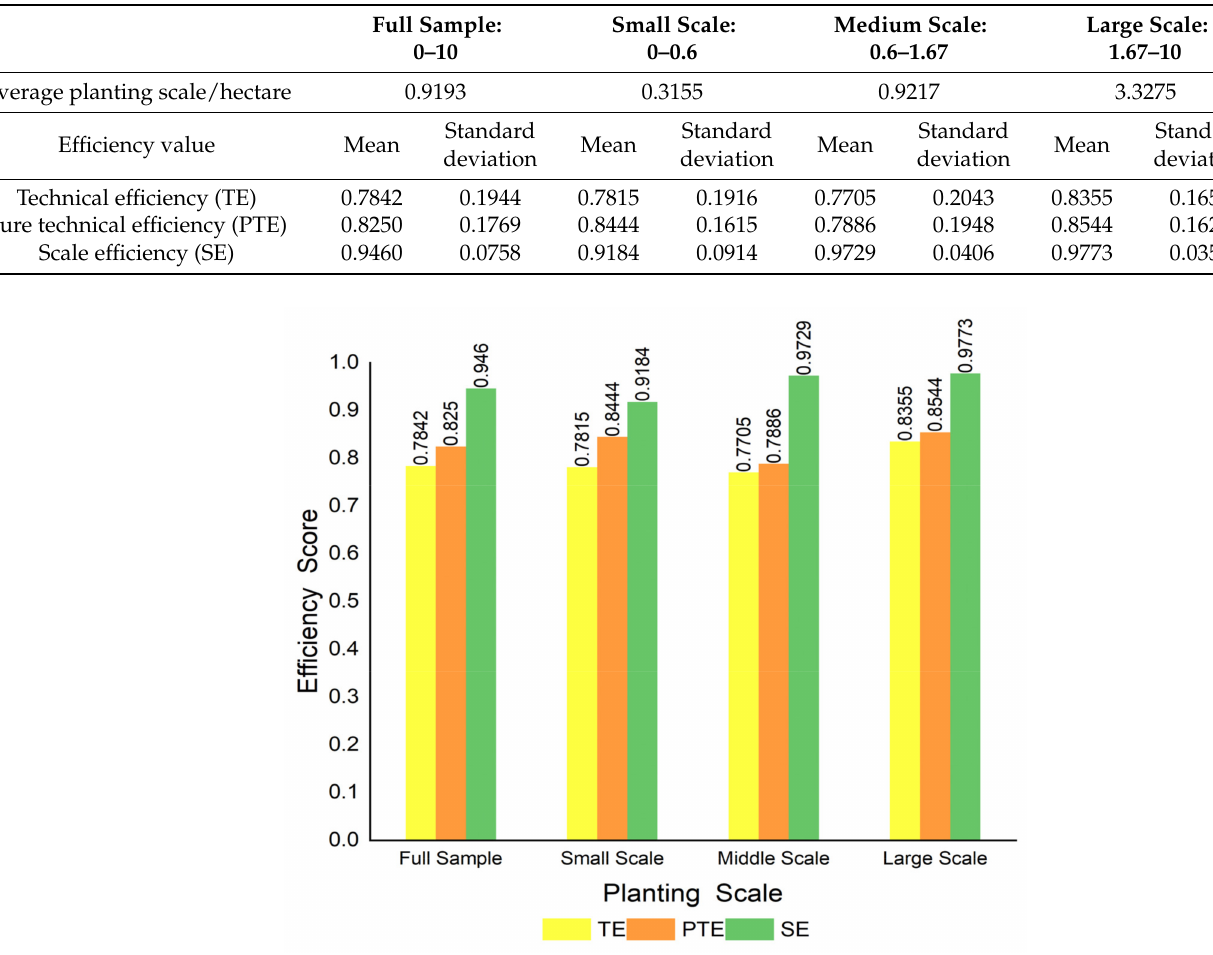
Figure 4. Technical, pure technical, and scale efficiency based on different planting